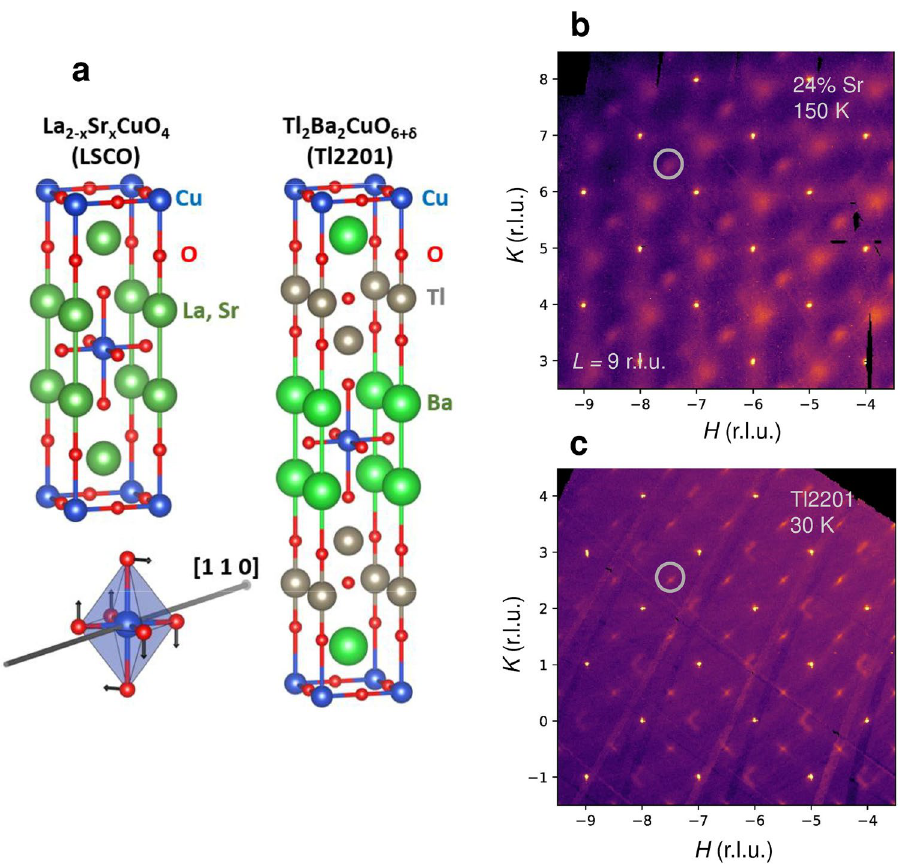
Figure 1. Short-range orthorhombic correlations in LSCO and Tl2201. ( a ) Crystal structures of LSCO and Tl2201. Both compounds crystallize in a body-centered tetragonal structure at high temperatures. The LTO distortion corresponds to tilts of the CuO 6 octahedra, leading to a doubling of the unit cell volume. ( b,c ) Diffuse X-ray scattering for ( b ) LSCO ( x = 0.24) and ( c ) slightly overdoped Tl2201. In both cases, the average structure is tetragonal at all temperatures. The HK 9 planes are shown, and clear diffuse peaks are observed at reciprocal space positions corresponding to the LTO superlattice (white circles). Black regions are detector artefacts that have been masked. Additional diffuse scattering of a different origin is present, including around forbidden integer Bragg positions. The sharp Bragg peaks correspond to the average tetragonal structure